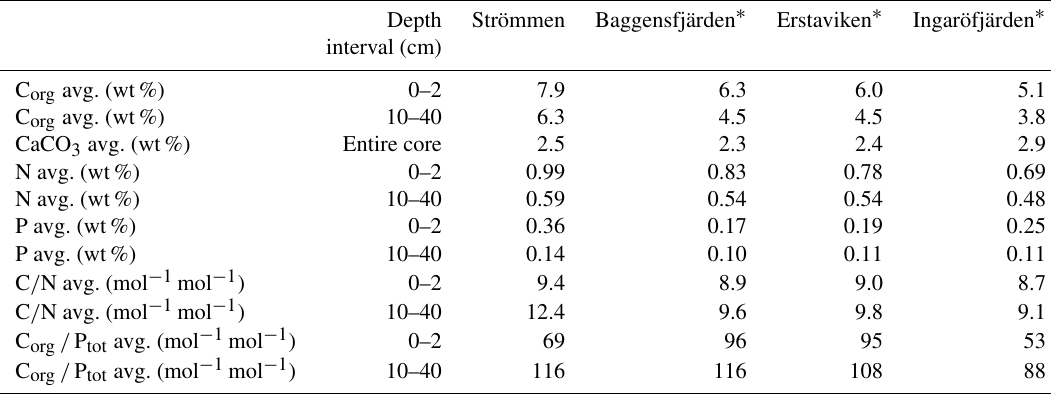
Table 4. Sedimentary concentrations of organic carbon (C org ), nitrogen (N), phosphorus (P) and calcium carbonate (CaCO 3 ) and C / N and C org / P tot ratios for the different study sites.